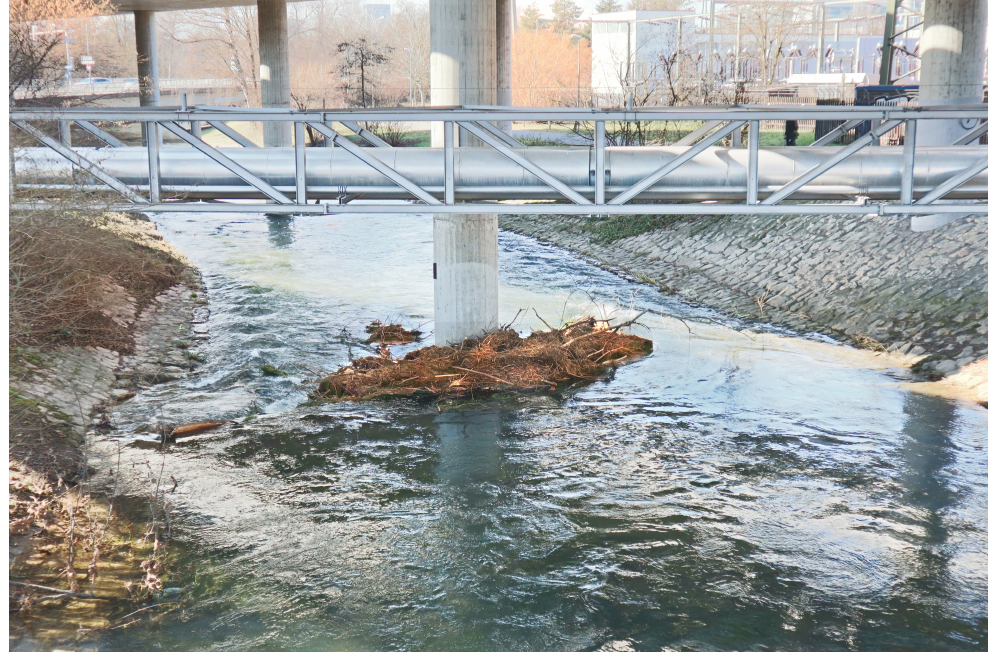
Figure 1. Naturally formed LW accumulation at the test site (River Glatt) in February, 2021. Flow di- rection from bottom to